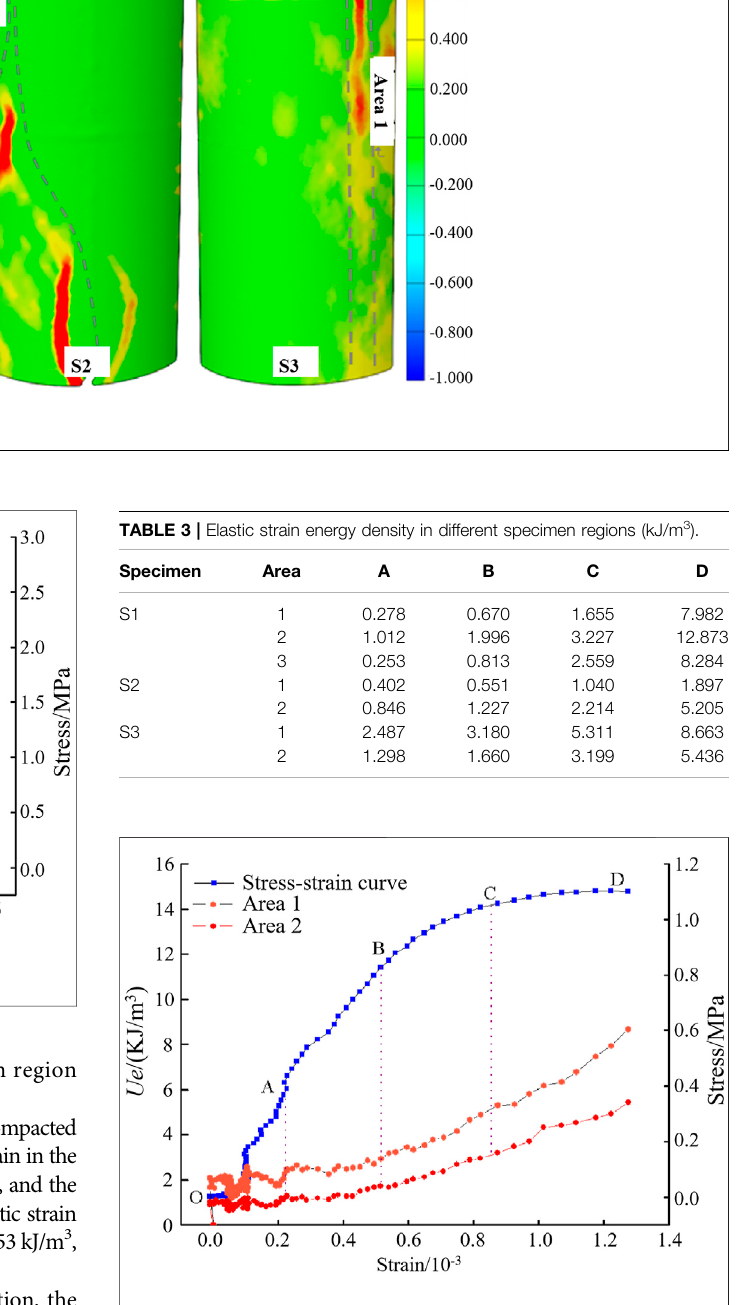
FIGURE 9 | Elastic strain energy evolution of S2